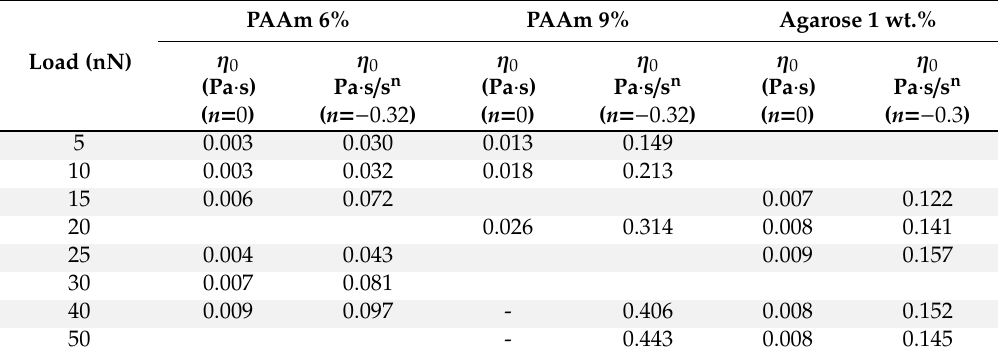
Table 6. Fitting Parameters for F vis for PAAm-6%, PAAm-9% and agarose hydrogels: Newtonian